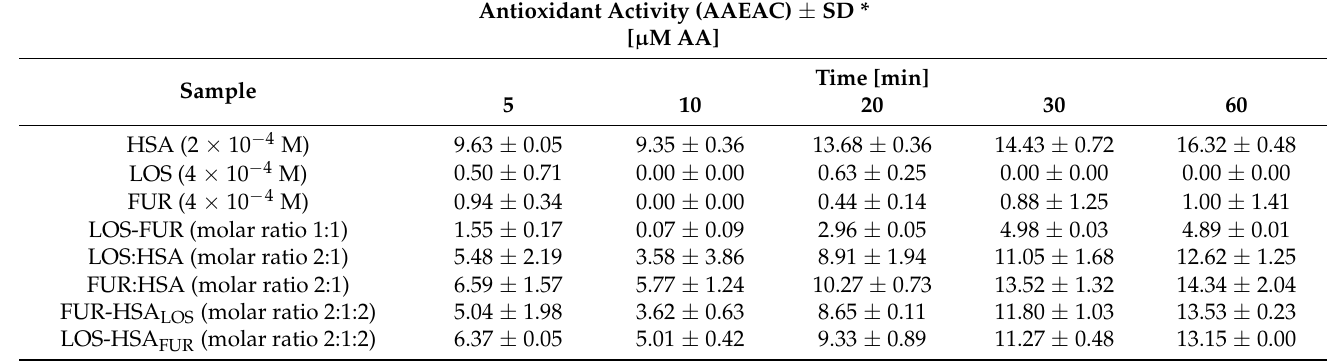
Table 5. The Total Antioxidant Capacity (AAEAC) (DPPH assay).